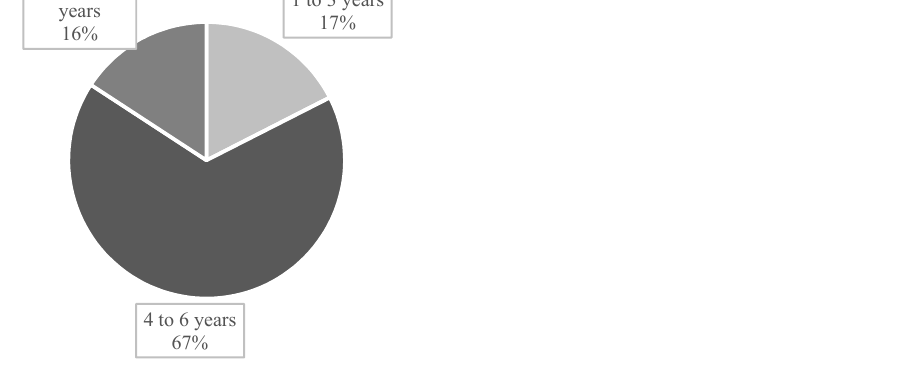
Figure 1. Experience in using online IT systems to support business operations.